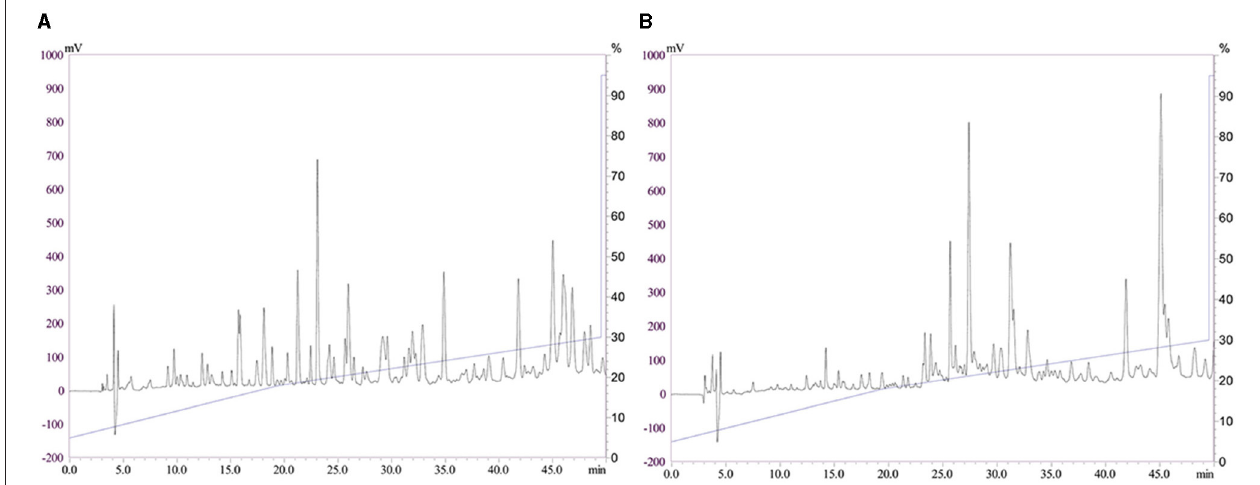
FIGURE 1 | Reversed phase high performance liquid chromatography profiles of casein phosphopeptides 1 and casein phosphopeptides 2 [CPP1 (A) and CPP2 (B) ].